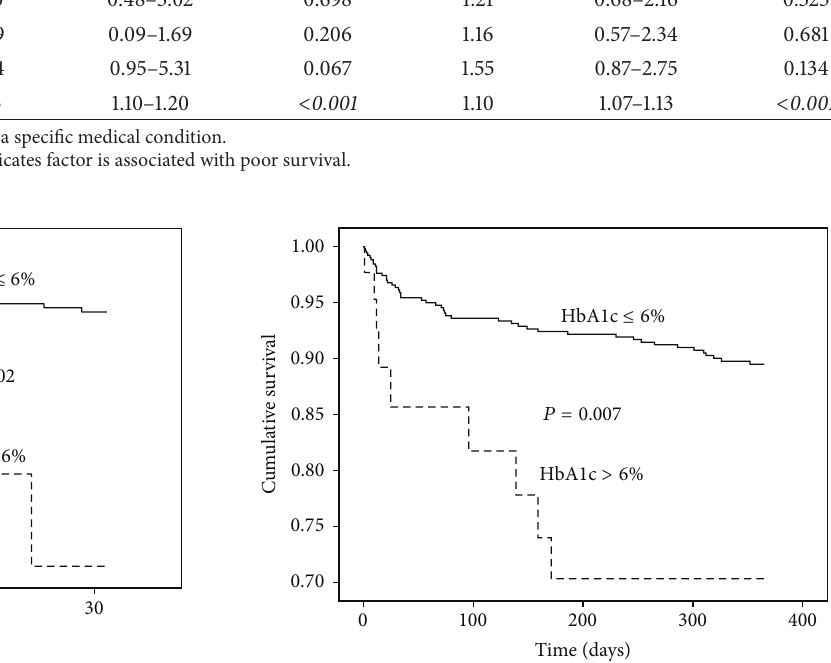
Figure 1: Cumulative survival during the first month after acute ischemic stroke ( 𝑛 = 39 deaths); stratification according to level of glycated haemoglobin, HbA1c.